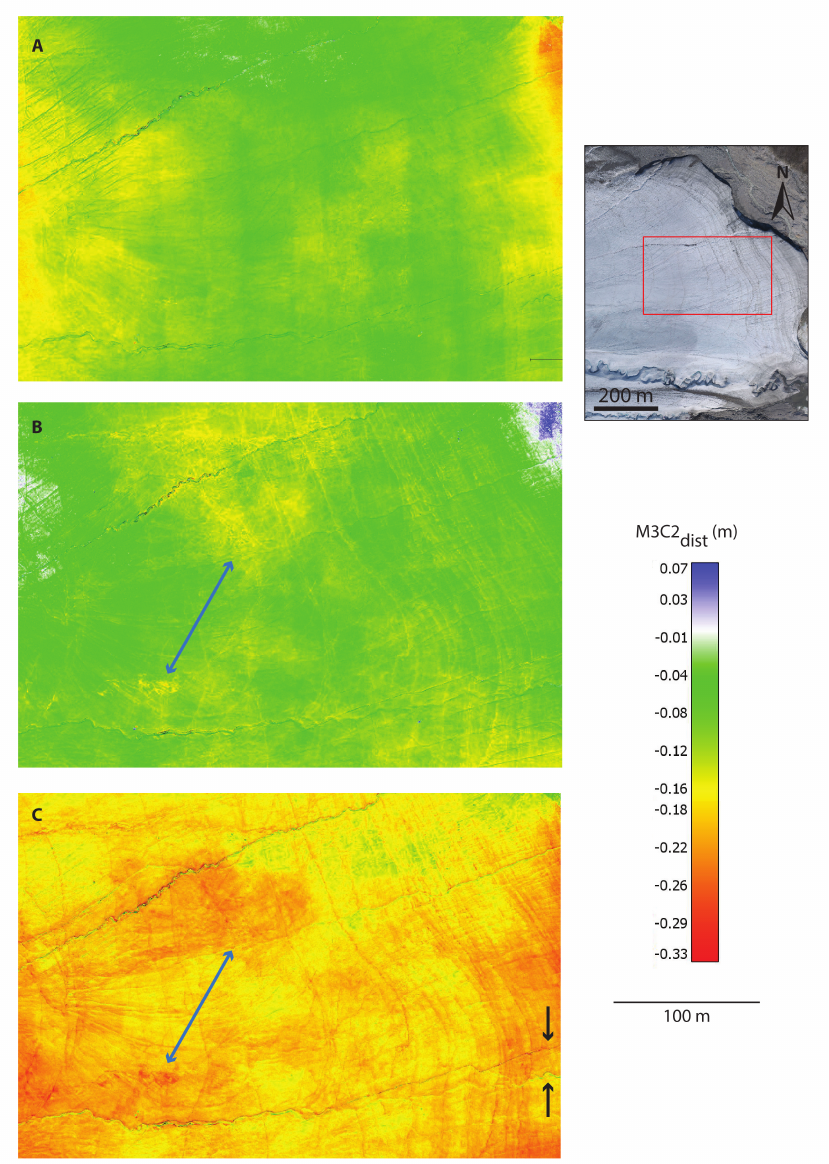
Figure 6. Ablation over: ( A ) 23–24 July; ( B ) 21–23 July; and ( C ) 21–24 July. Blue arrows indicate regions of enhanced melt with higher concentrations of supraglacial debris. Black arrows indicate the active (upper) and abandoned (lower) supraglacial